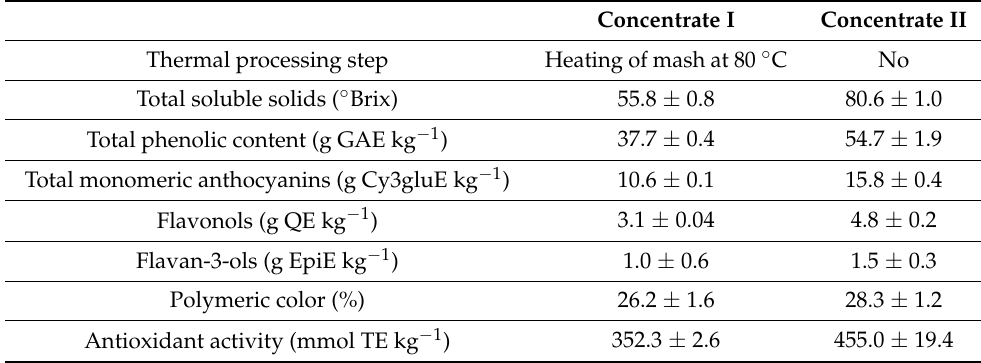
Table 1. Analytic data of the initial elderberry juice concentrates 1